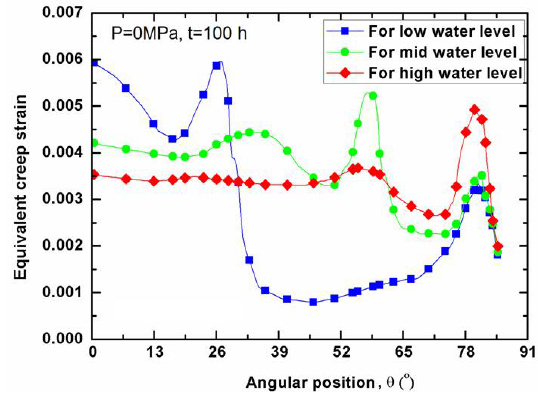
Figure 10. Effect of creep on plastic strain distribution for RPV with mid water level.